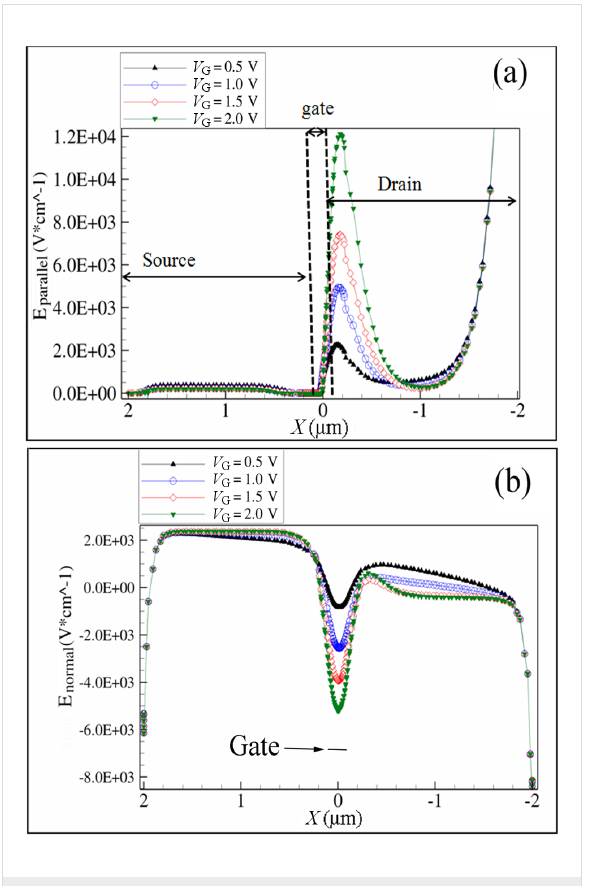
Figure 7: Simulated (a) parallel and (b) normal electric field along a horizontal cut line at the center of the channel (source side to drain side), V G = 0.5, 1, 1.5, and 2.0 V, V ds = − 1.0